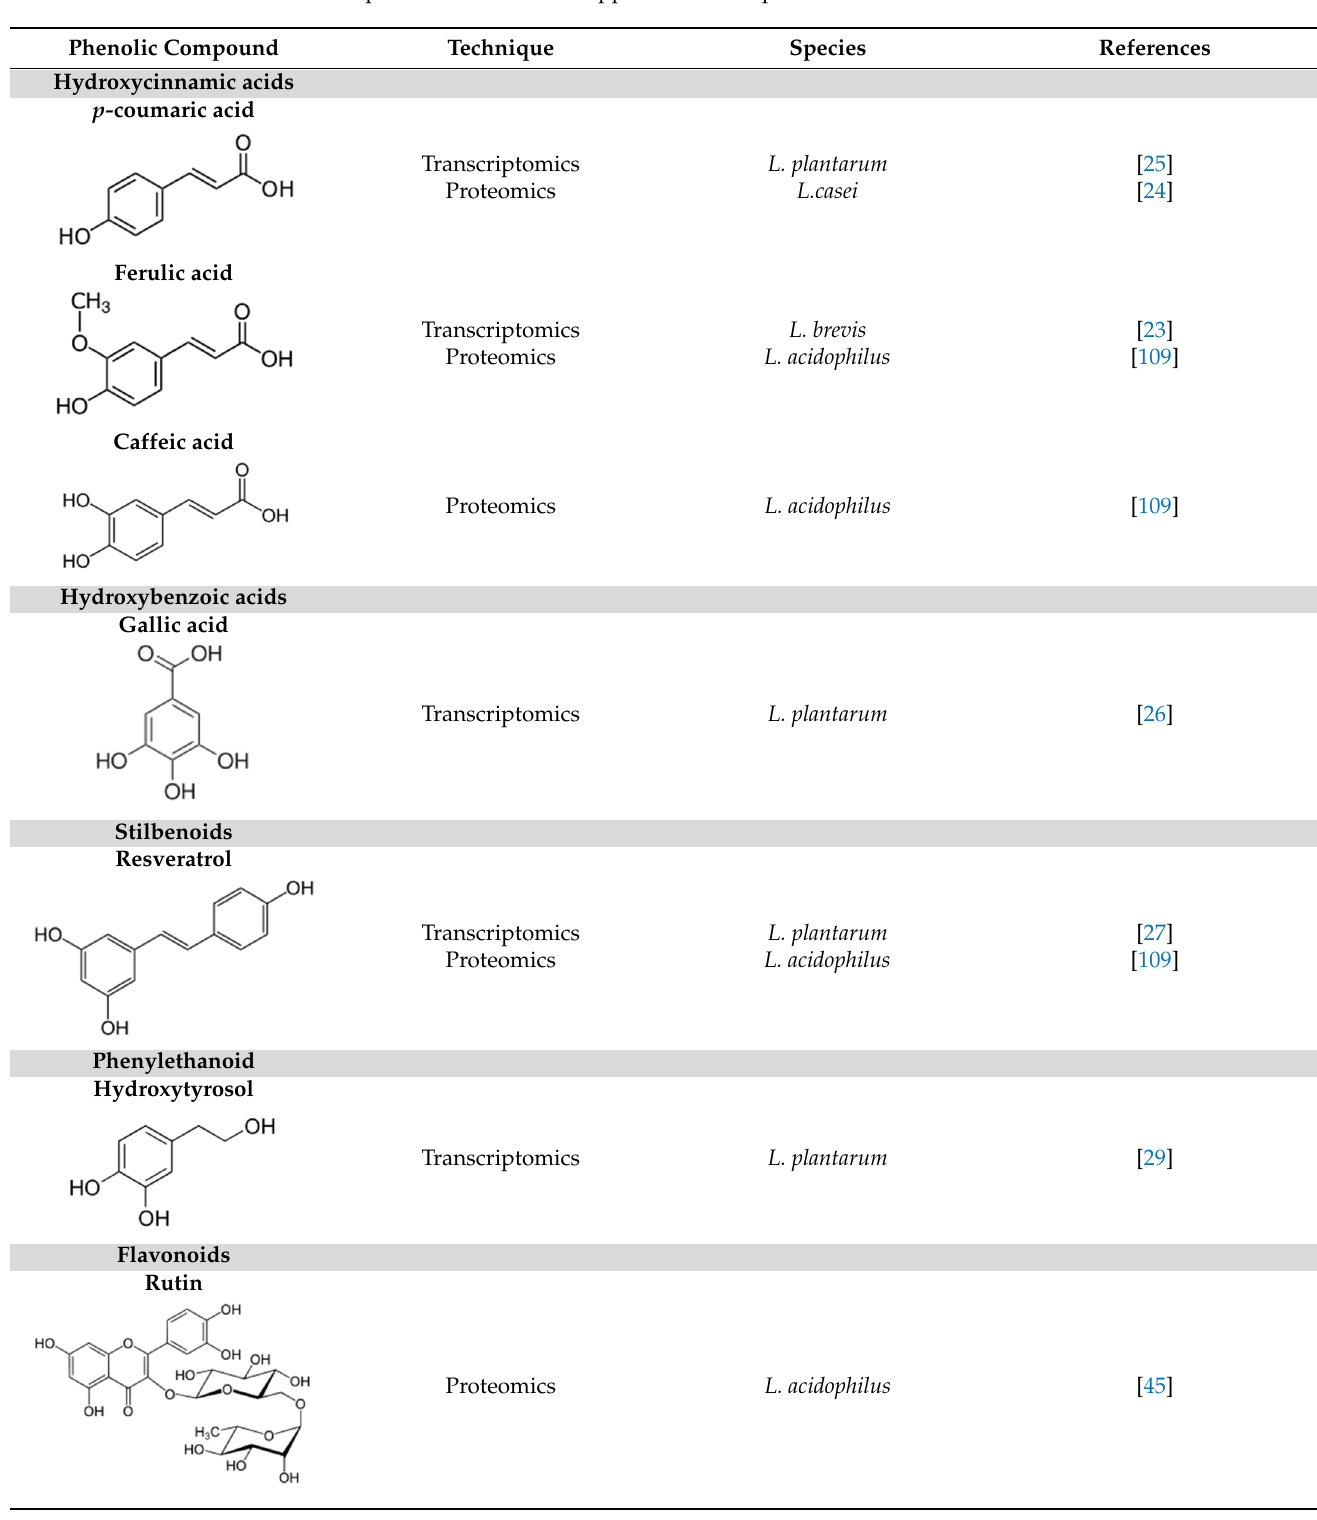
Table 5. Structural formulas of plant phenolic compounds and techniques used to study the molecular responses of Lactobacillus spp. to these compounds.